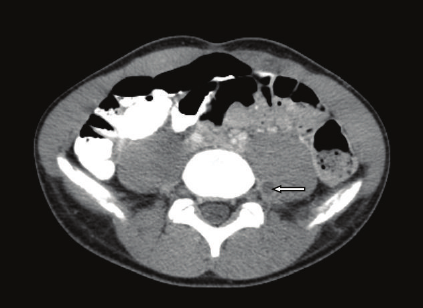
Figure 3: There is thrombus noted within a paraspinal collateral vein (white arrow).